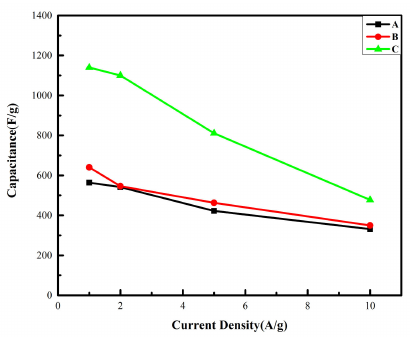
Figure 5. The specific capacitance of the di ff erent Co 3 O 4 electrodes at di ff erent current densities: A, B and